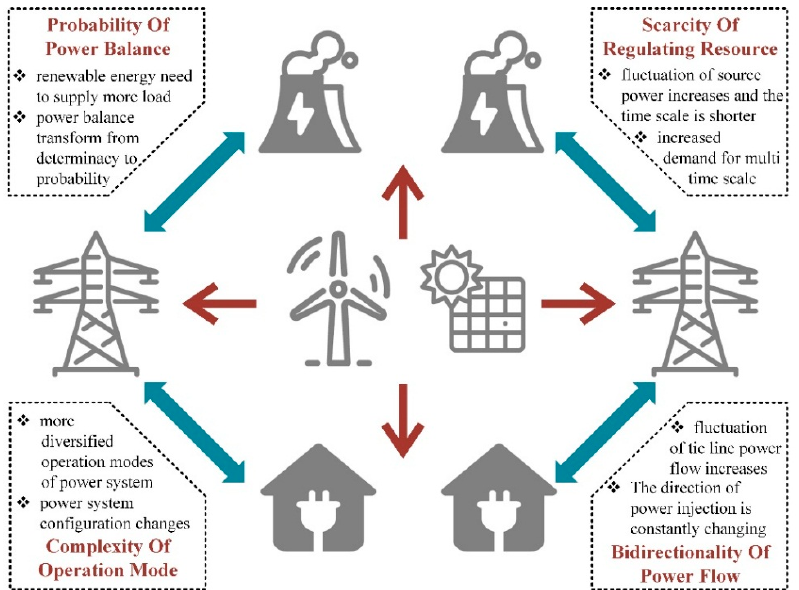
Figure 1. Typical characteristics of high penetration of the renewable energy integrated system.